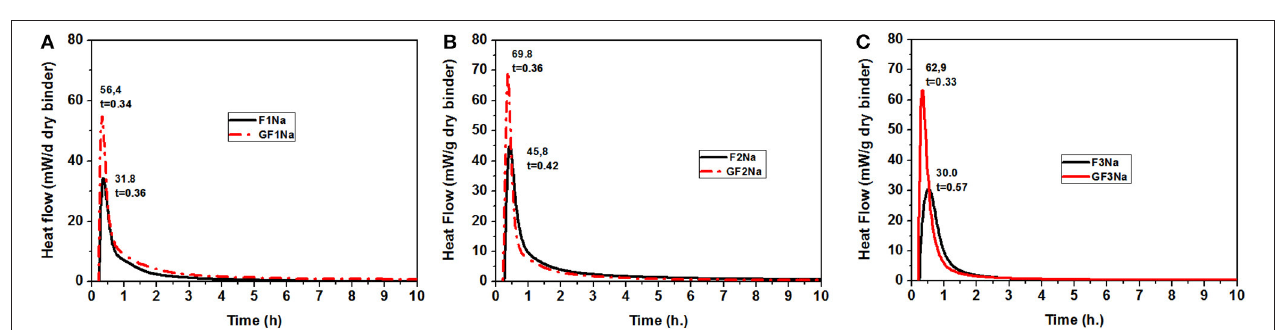
FIGURE 5 | Rate of Heat release for the different coal fly ashes activated with an 8 M NaOH solution at 85 ◦ C (A) F1Na (unground) and GF1Na (ground) (B) F2Na (unground) and GF2Na (ground) (C) F3Na (unground) and GF3Na (ground).